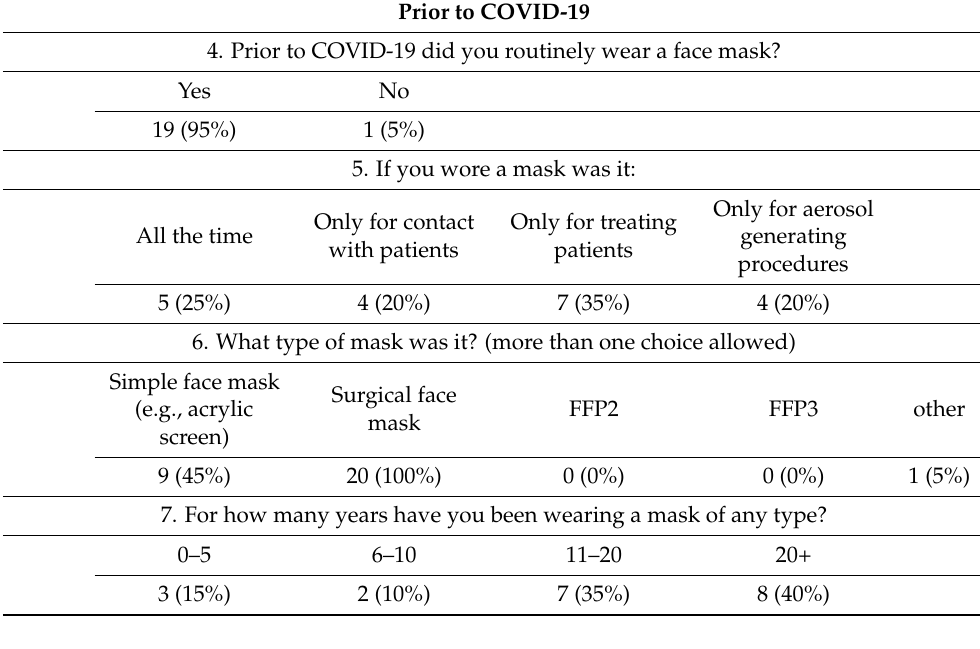
Prior to COVID-19